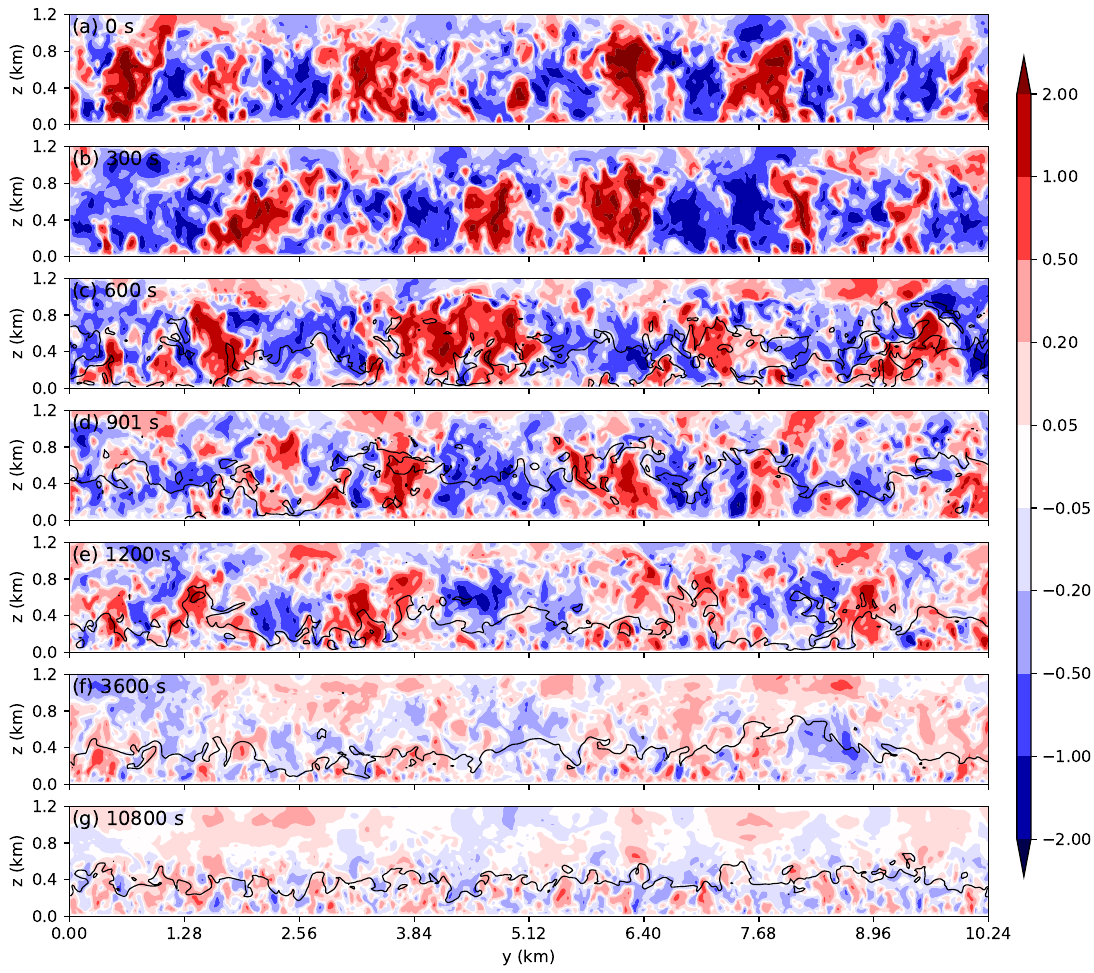
Figure 9. Vertical velocity fields at x = 1270 m and t − t c = ( a ) 0, ( b ) 300, ( c ) 600, ( d ) 901, ( e ) 1200, ( f ) 3600, and ( g ) 10,800 s in the advective CBL. Contours of 301.51 K potential temperature are added in ( c – g